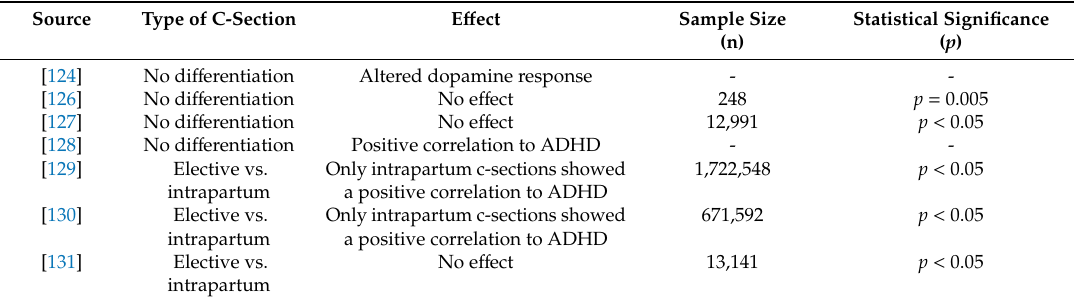
Table 2. List of seven studies that tested the e ff ects of c-section delivery on the development of